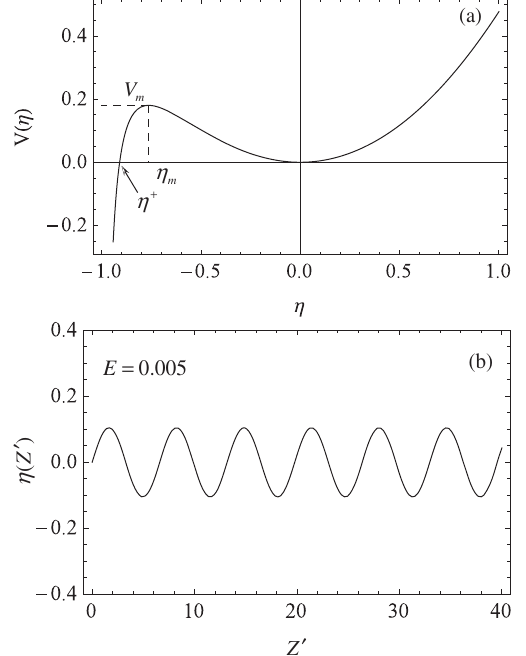
FIG. 16. Plots are shown for (a) V ð η Þ versus η , and (b) η ð Z 0 Þ versus Z 0 , obtained from Eq. (94) for M 2 ¼ 0 . 09 , η 0 ð 0 Þ ¼ 0 . 1 , E ¼ ð 1 = 2 Þ½ η 0 ð 0 Þ(cid:4) 2 ¼ 0 . 05 , η þ ¼ − 0 . 91 , η 0 . 181 V ð η m Þ ¼